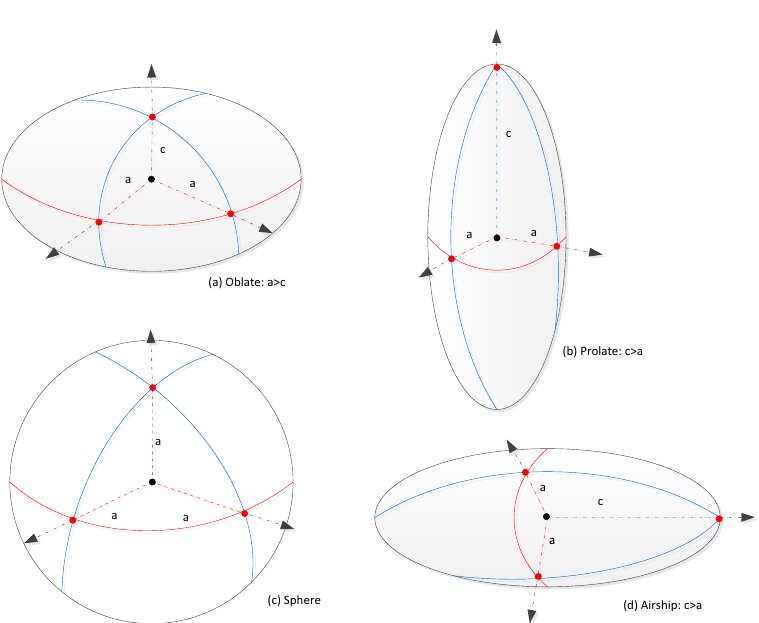
Figure 1. Oblate, prolate, sphere, and airship shapes of